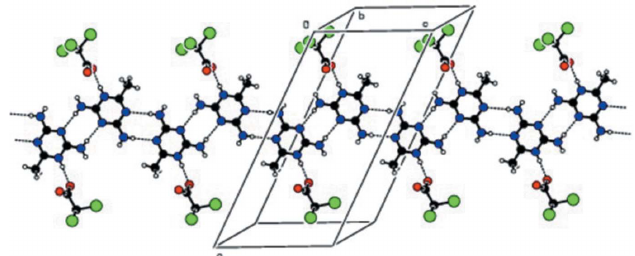
Figure 2 A packing view showing the centrosymmetric N—H (cid:2)(cid:2)(cid:2) N hydrogen- bonded cation pairs with TCA anions, extending into chains along the c - axis direction. Water molecules are omitted.